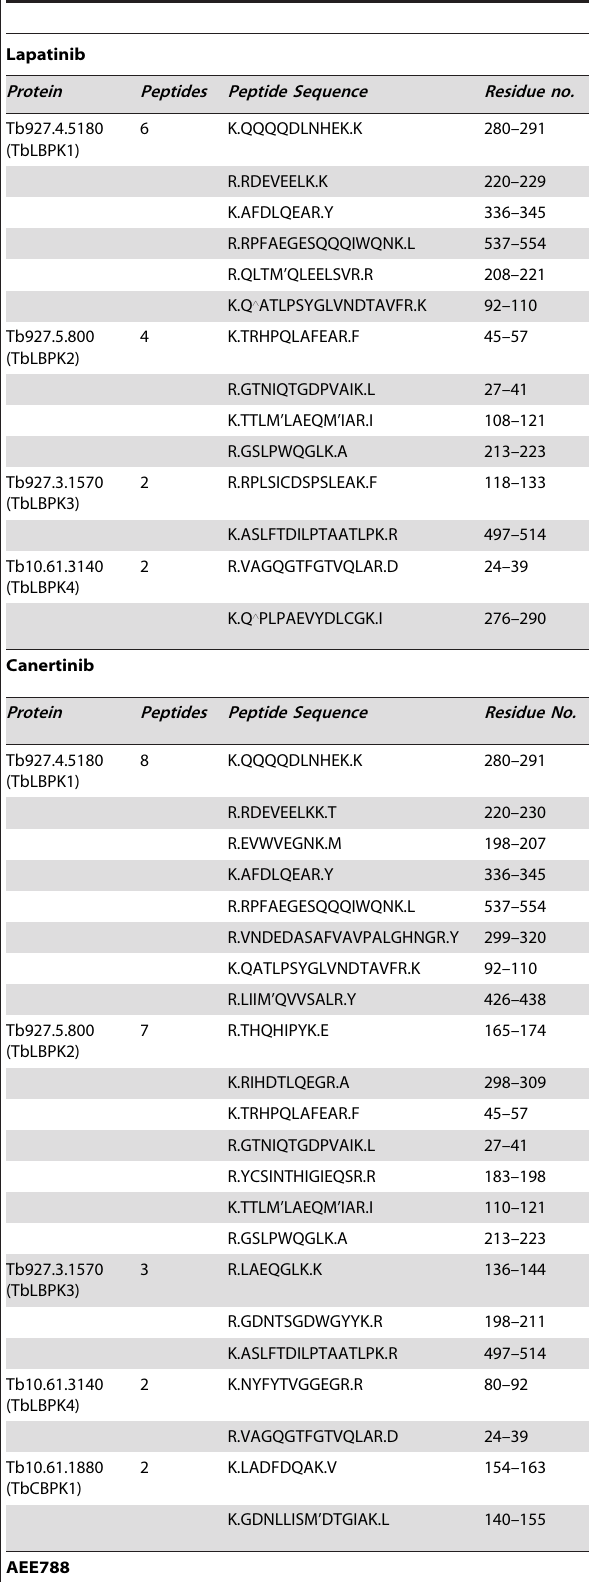
Table 1. Protein kinases eluted with drugs after 1 M KCl wash of the affinity